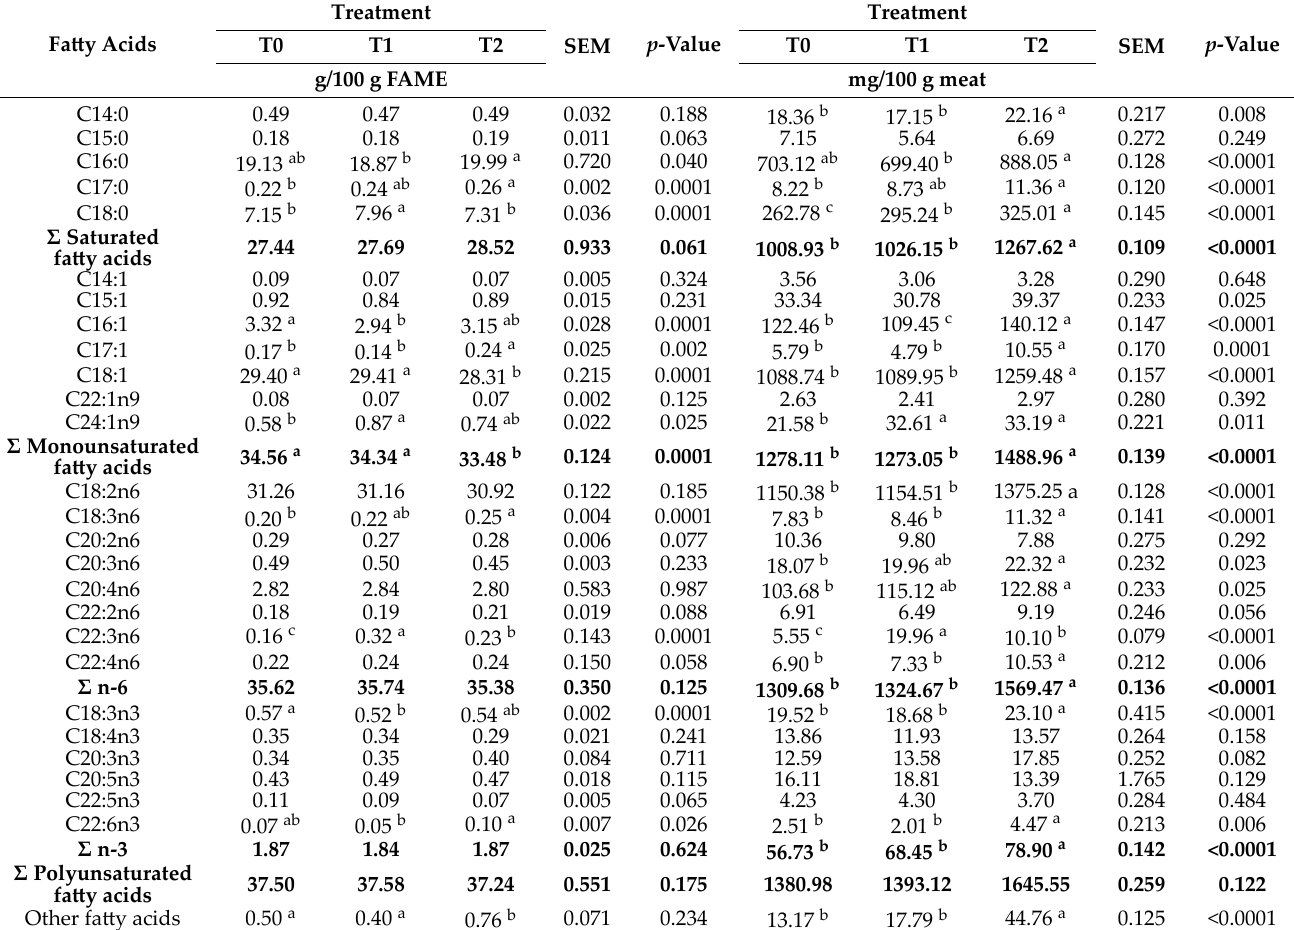
Table 6. Treatment effects on the fatty acid profile of thigh